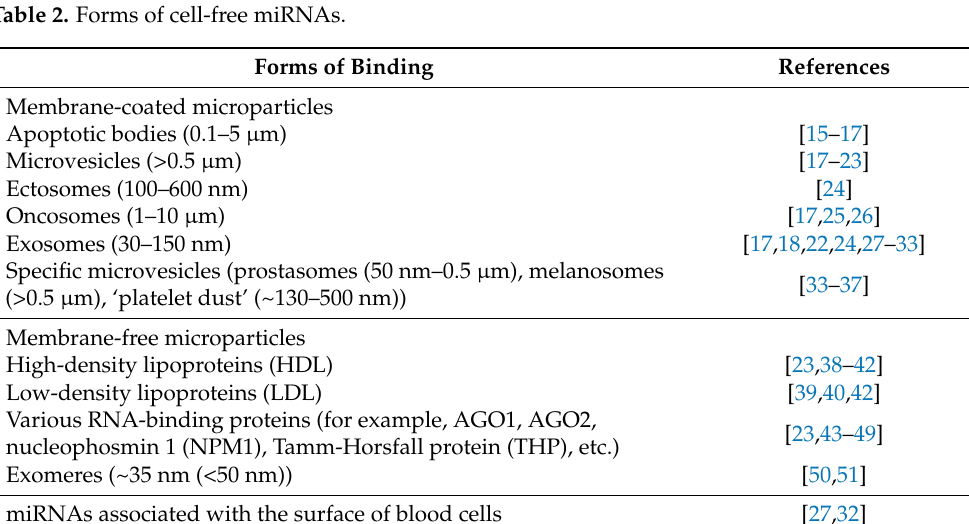
Table 2. Forms of cell-free miRNAs.